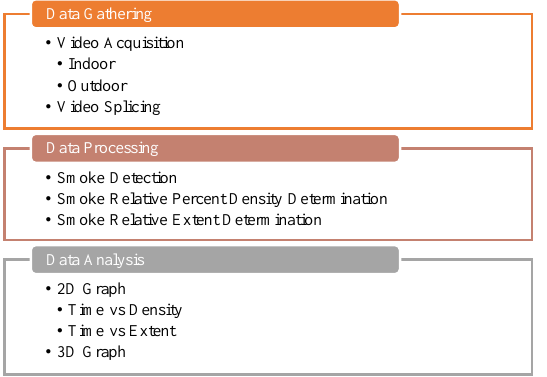
. Figure 2. General Flowchart for the Methodology